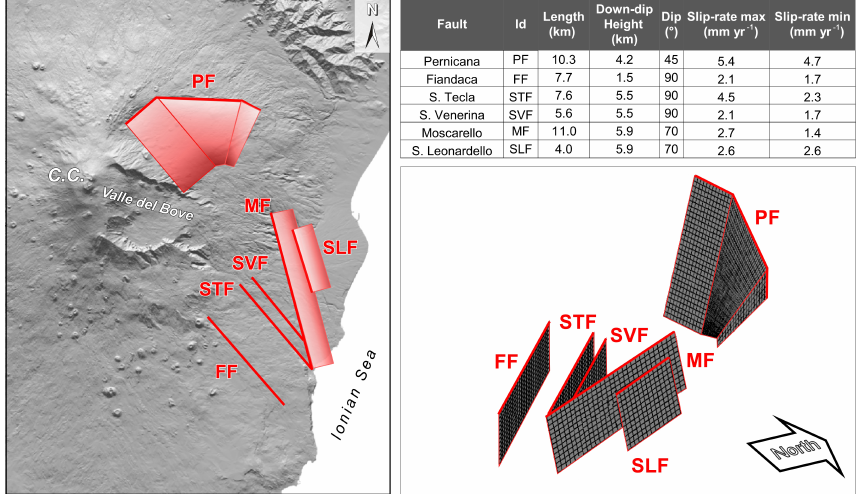
Figure 9. Pattern of individual sources used in the geological model and related geometric–kinematic parameters: red boxes in the left frame represent the projection at the surface of the fault planes, while lines indicate the vertical planes. Note that lengths refer to the seismogenic fault segments only, whereas the ones governed by prevailingly creeping behavior are not considered.